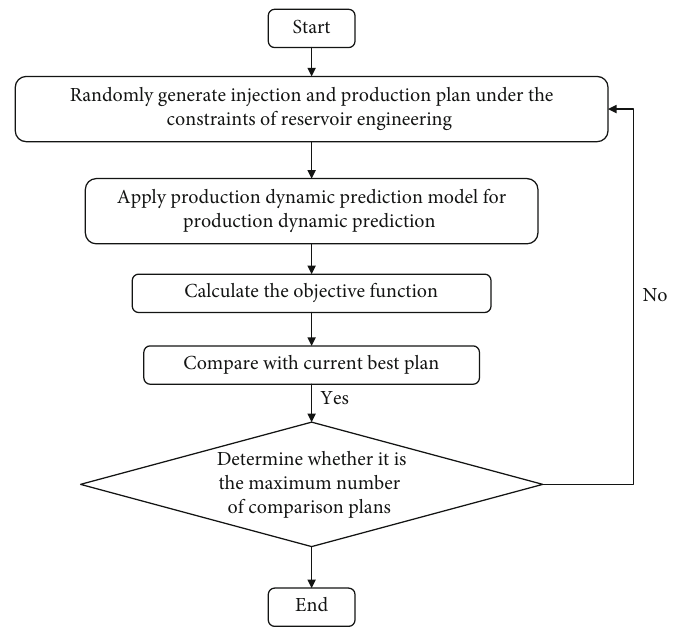
Figure 6: Scheme optimization fl ow